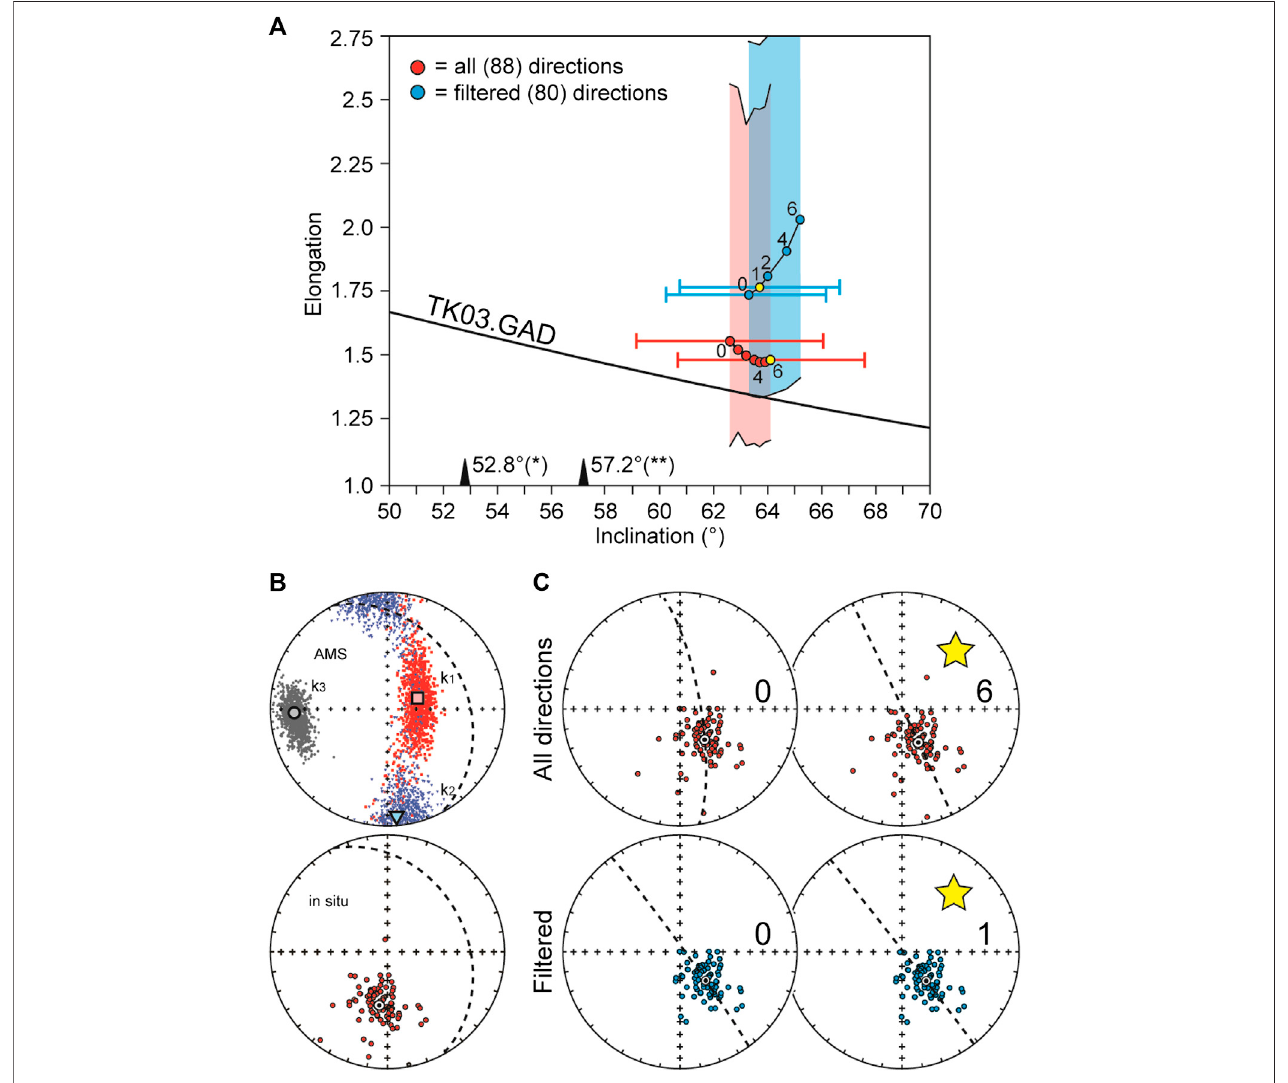
FIGURE8 | Paleomagnetic directions, anisotropy ofmagnetic susceptibility(AMS), and distribution shape analysis ofSommet-Khian. (A) Elongation vs. inclination (E/I) of the paleomagnetic distribution for the whole (red) and the fi ltered (blue) dataset, compared with the value expected by the TK03.GAD model; the yellow dots representthe “ unstrained ” conditionwheretheelongation directionisparalleltotheaveragedeclination,shownwiththeinclination95%con fi denceangledeterminedby applying standard Fisher (1953) statistics; the elongation values of the original and “ unstrained ” steps are shown with the 90% con fi dence zone determined by meansof 1,000bootstrapped pseudo-dataset expectedinclination calculatedfrom thecompilations ofTorsvik et al. (2012*) and Veevers and Li (1991**) are shown. (B) Upper projection: AMS from Sommet-Khian; k1 (red symbols), k2 (blue symbols), and k3 (gray symbols) are respectively the major, intermediate, and minor axes of the AMS, with average direction of the eigenvectors; lower projection: characteristic remanent magnetization (ChRM) directions from Sommet-Khian in insitu coordinates, together with the Fisher (1953) mean; in both projections the dashed circle is the bedding plane; data from Dallanave et al. (2020). (B) Effect of the “ unstraining ” on the whole(red) and fi ltered(blue)dataset fromSommet-Khian; the yellow starindicates theconditionwhere theelongation direction (dotted line) isparallel tothedeclination; the number within the diagrams indicate the matrix used ( Table 4 ) and the associated E/I couple in panel A.